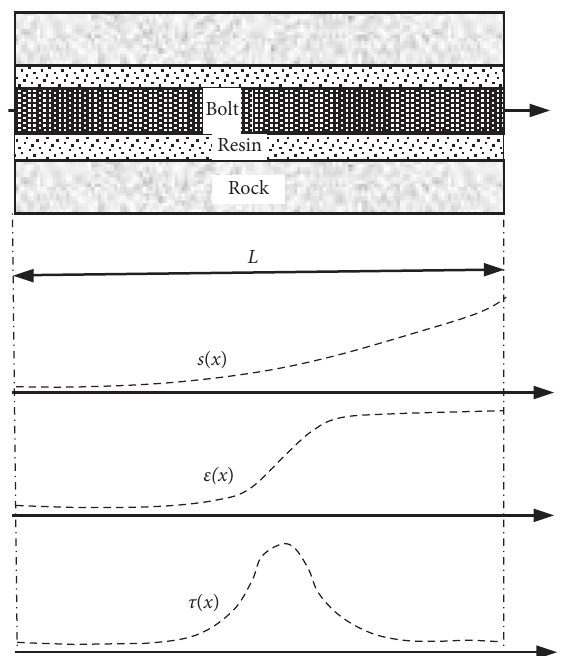
Figure 2: Analytical model of a fully grouted bolt subjected to a pull load at the bolt end